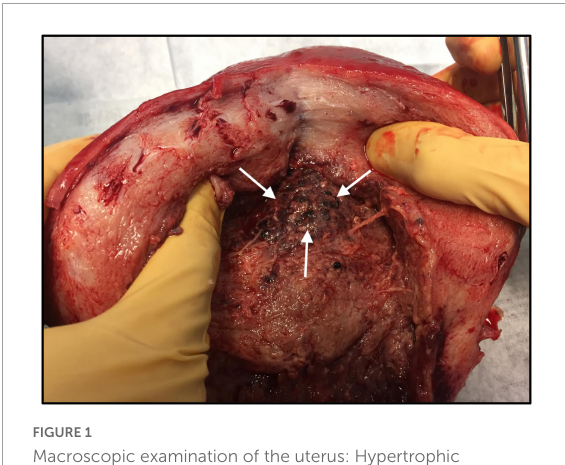
FIGURE1 Macroscopic examination of the uterus: Hypertrophic post-partum uterus with necrotic tissue (white arrows), following severe Streptococcus pyogenes puerperal sepsis.